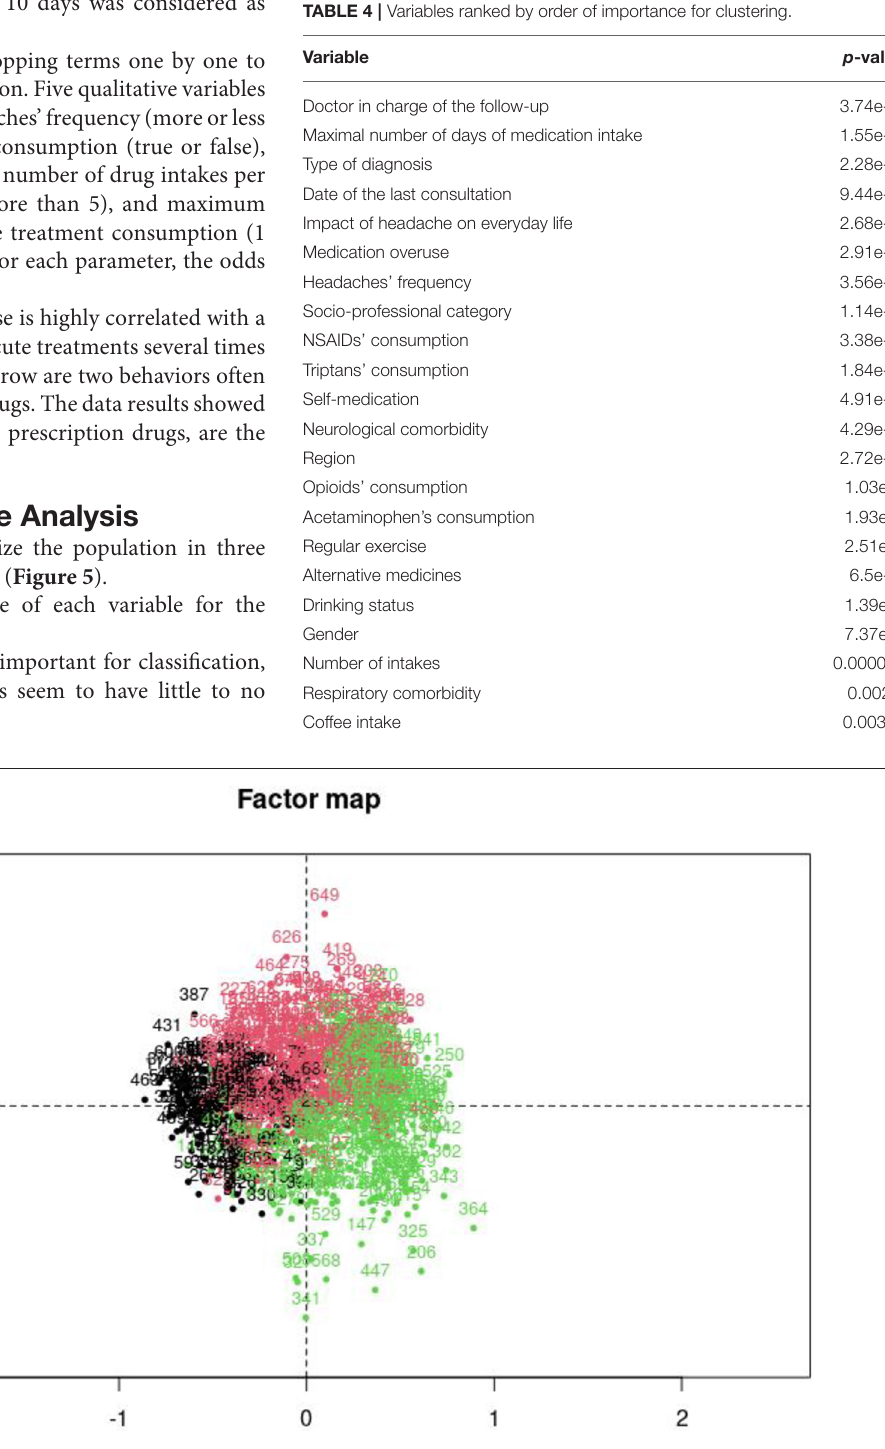
FIGURE 5 | Factor map of the multiple correspondence analysis. Cluster 1, independent profile; Cluster 2, mixed profile; Cluster 3, medication overuse profile.